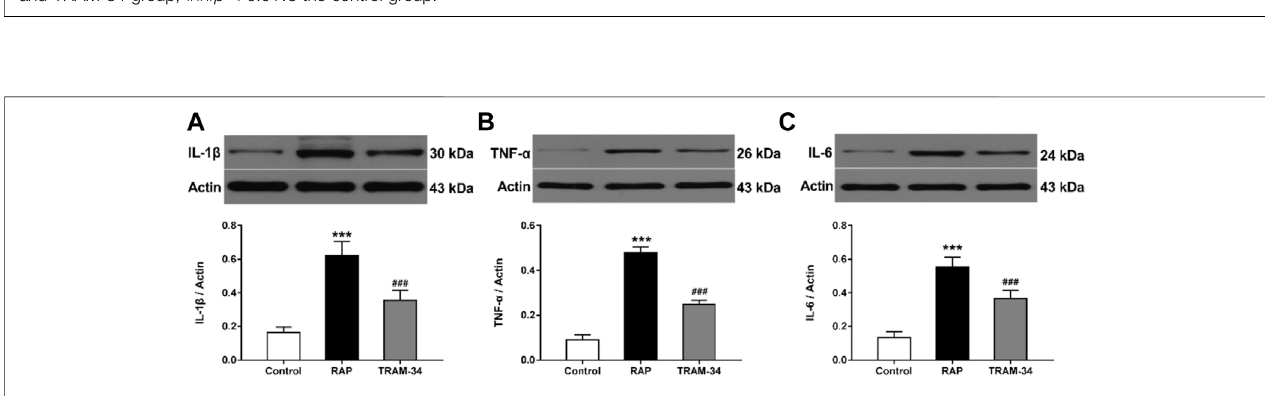
Frontiers in Physiology |